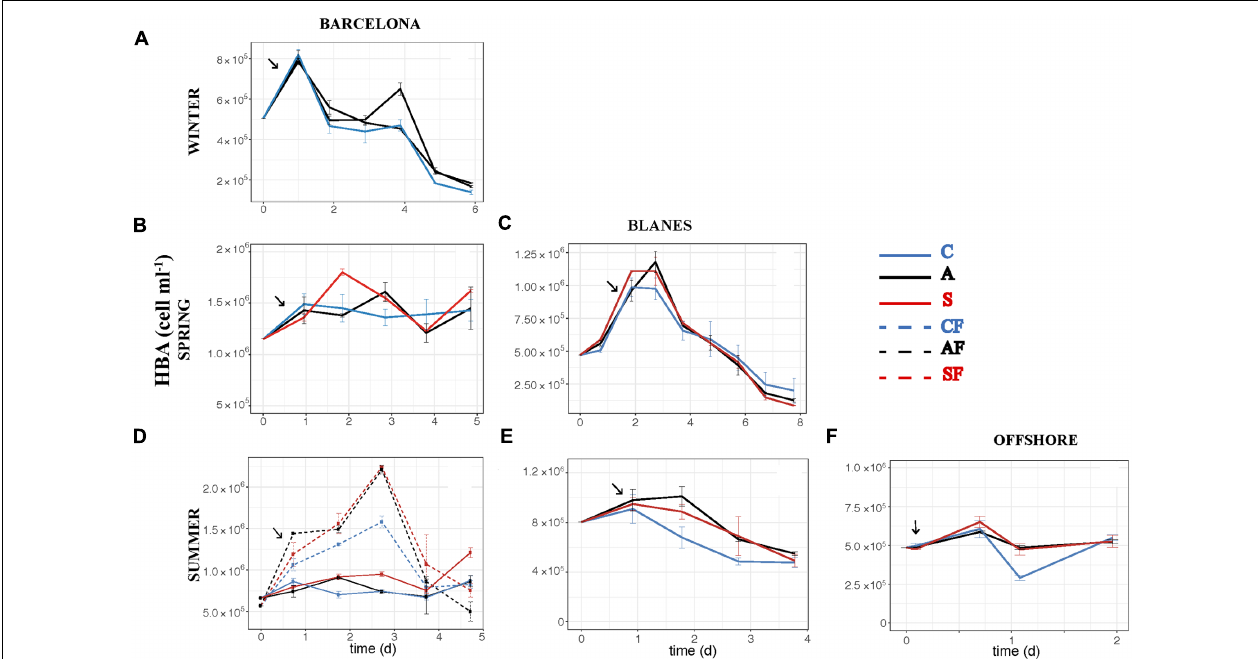
FIGURE 3 | Heterotrophic bacterial abundance – HBA (cell ml − 1 ) – over the incubation time in the six experiments: (A) WI-BCN, (B) SP-BCN, (C) SP-BLA, (D) SU-BCN, (E) SU-BLA, (F) SU-OFF. Error bars represent the standard error from two replicate containers. Arrows point to the moment of aerosol additions. C, controls; A, anthropogenic; S, Saharan; CF, controls filtered by 0.8 µ m; AF, anthropogenic filtered by 0.8 µ m; SF, Saharan filtered by 0.8 µ m. Note that in the winter experiment there are two A treatments.